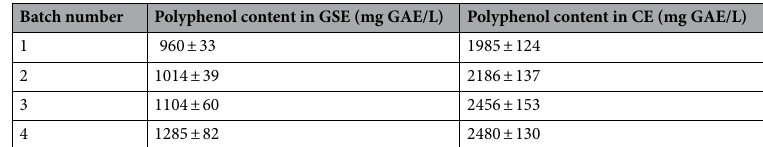
Table 1. The total polyphenolic content in GSE and CE was calculated according to the Folin-Ciocalteu method. Polyphenol content is expressed as milligrams of gallic acid equivalents (GAE) per liter of extract. All values are presented as the mean ± SD (n =